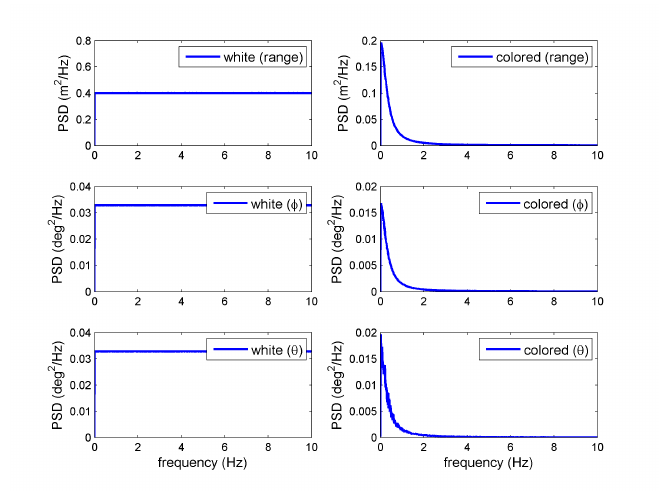
Figure 19. Power spectral density function over the frequency range (Case 2C).